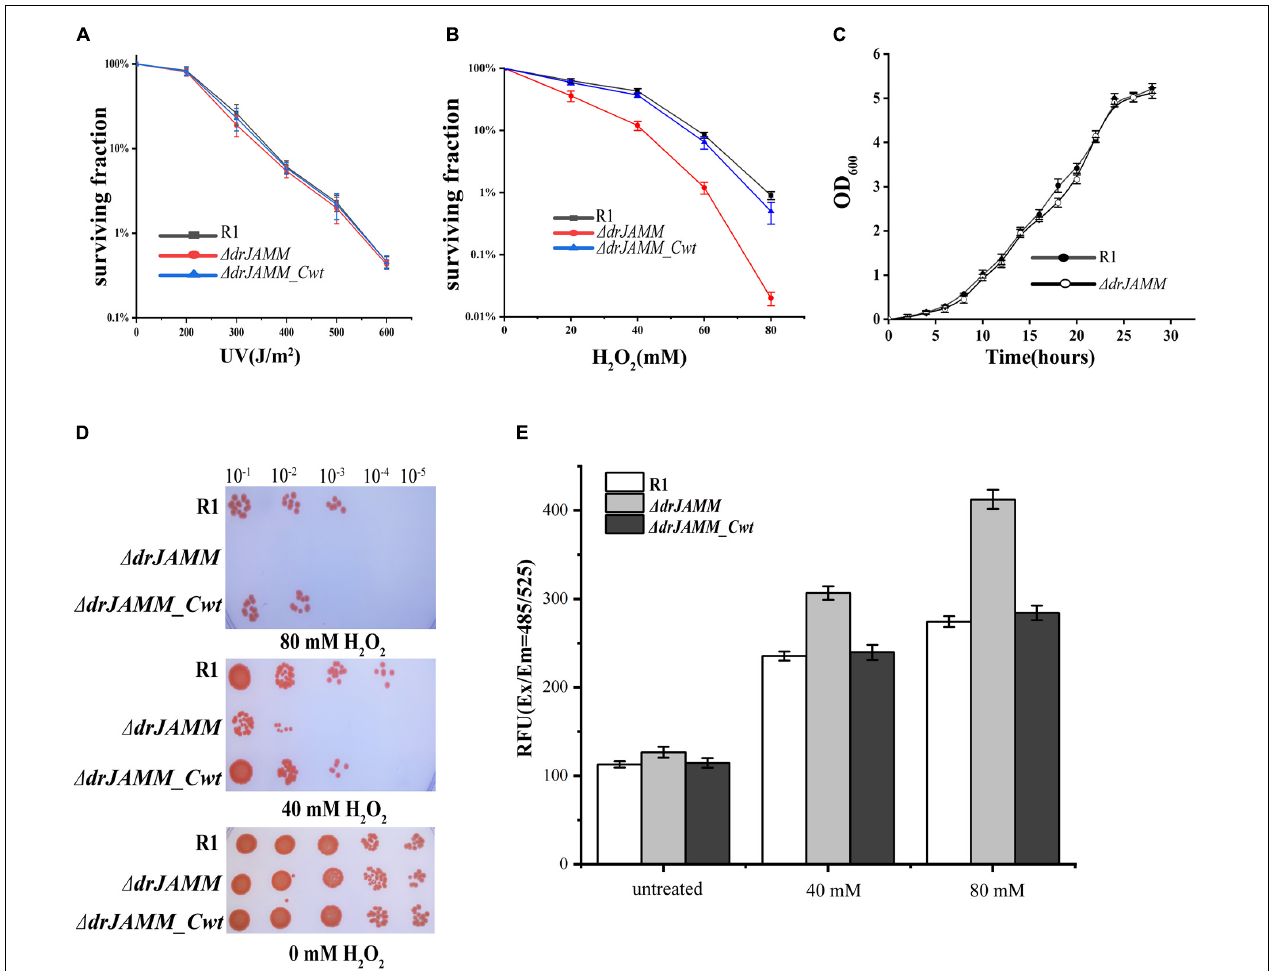
FIGURE 2 | Phenotypes of the D. radiodurans wild-type strain (R1), the mutant (cid:49) drJAMM ( (cid:49) dr_0402 ), and (cid:49) drJAMM compensatory stain ( (cid:49) dr_0402_Cwt) . (A,B) Survival curves of the strains under H 2 O 2 (0–80 mM) and UV (0–600 J/m 2 ) treatment, respectively. (C) Growth curves of D. radiodurans wild-type strain and (cid:49) drJAMM mutant strain. The data represent the means of the three replicates. (D) Following incubation with 0, 40, or 80 mM H 2 O 2 for 30 min, the strains were spotted onto TGY plates. The numbers above the figure represent the dilution ratio of cultures. (E) The level of ROS accumulation in cells after 0, 40, and 80 mM H 2 O 2 treatment, respectively. “Untreated” represents a concentration of 0 mM H 2 O 2 . RFU means relative fluorescence units.